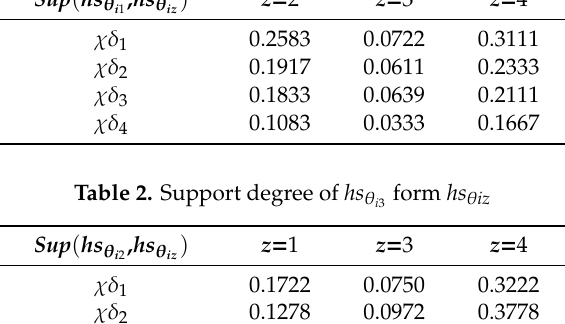
form hs θ iz i 3